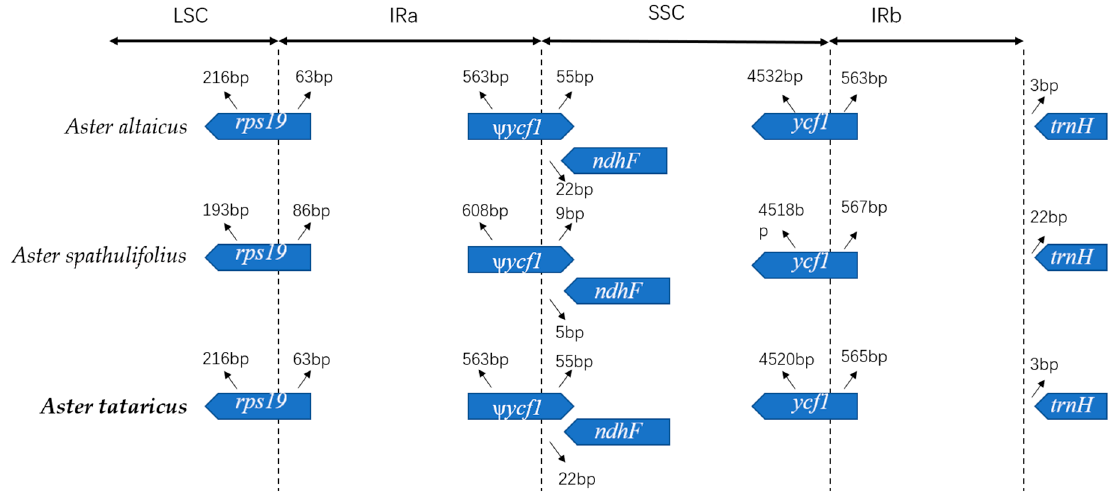
Figure 4. Comparison of border distance between adjacent genes and junctions of the LSC, SSC, and two IR regions among the chloroplast genomes of three Aster species. Boxes below the main line indicate the adjacent border genes. The figure is not to scale with respect to sequence length and only shows relative changes at or near the IR/SC borders.